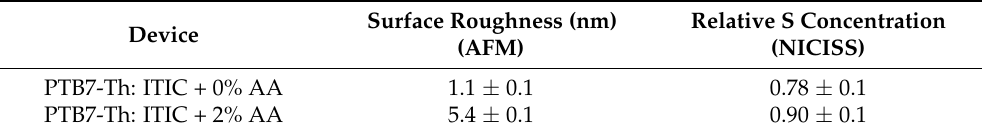
Table 2. Surface roughness and S relative concentration of the PTB7-Th: ITIC device with and without AA. A relative concentration of 1 would mean that the surface concentration is the same as the bulk concentration.